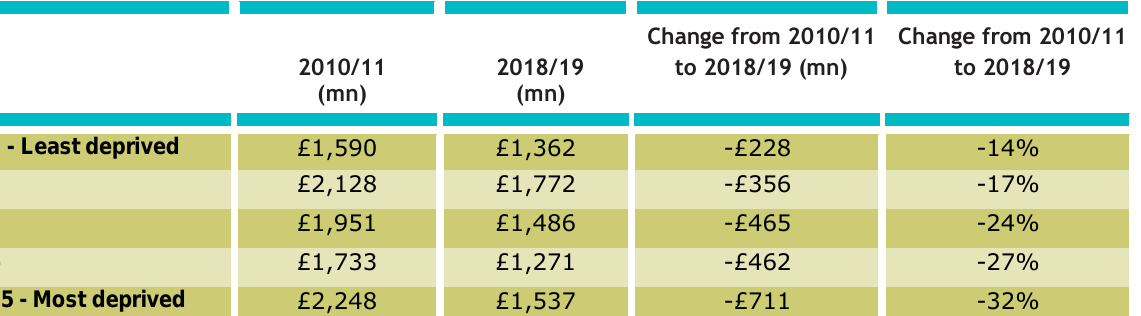
Table 2 : Estimated funding for children and young people’s services by deprivation in real terms